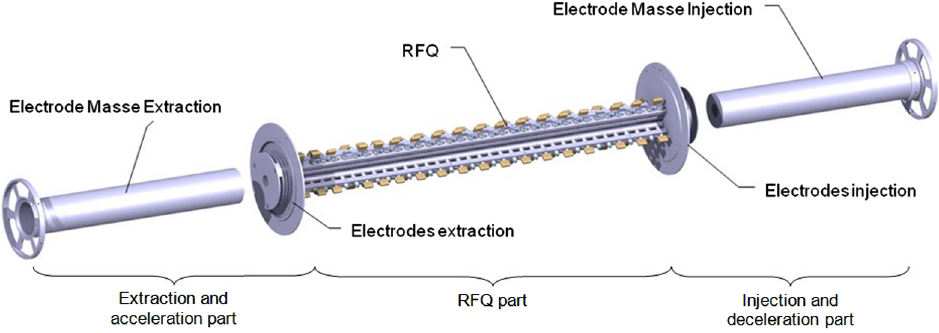
FIG. 1. Schematic of the SHIRaC optics system: Design of the three parts of